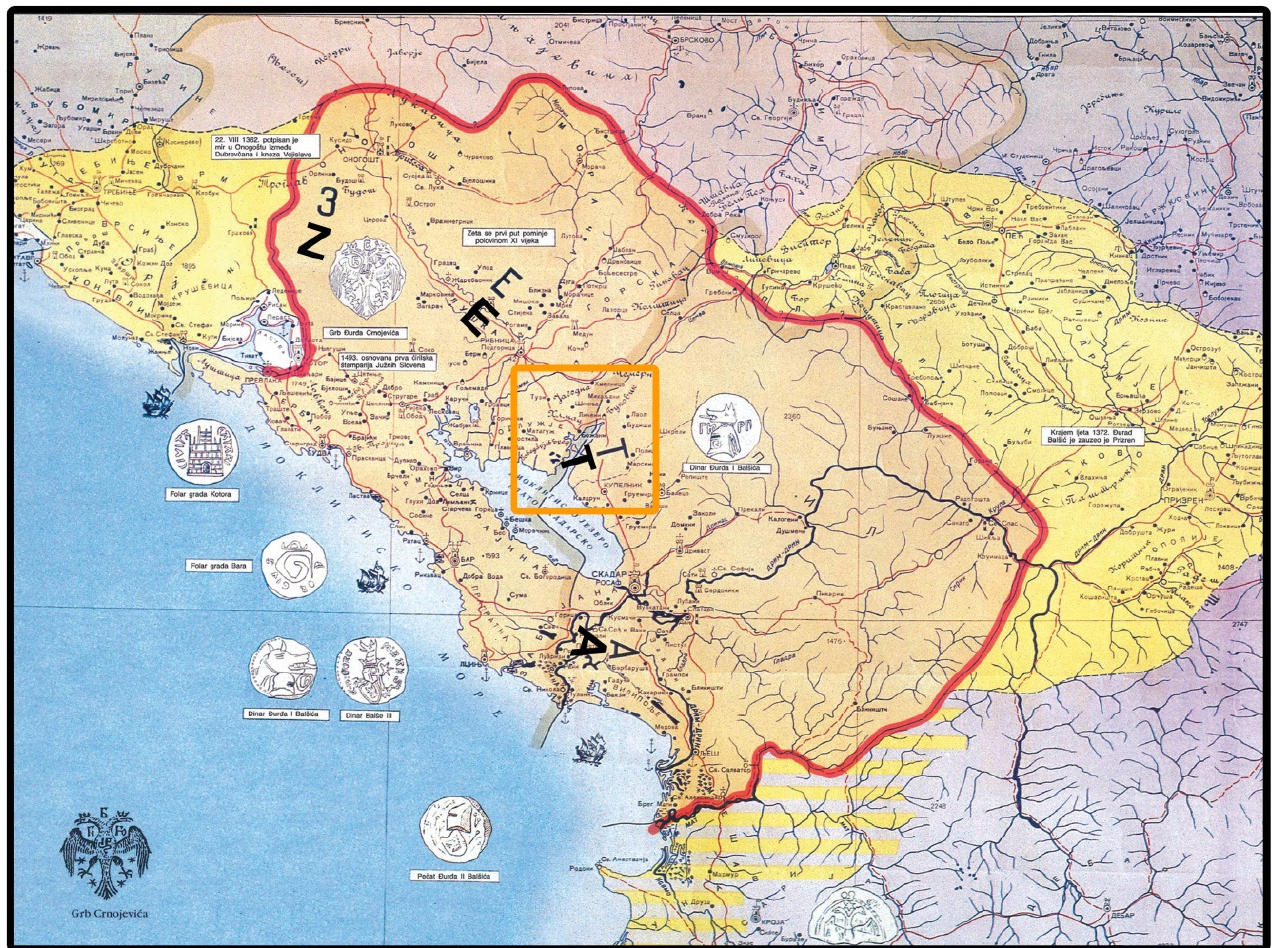
Figure 2. The Zeta region in the 13th century encompassed the area from the Bay of Kotor (Boka Bay) to the rivers Bojana and Drim, and from Ostrog to Podgorica and Skadar Lake. At the end of the 14th century, the territory of Zeta was divided into the Upper and Lower. The Upper Zeta consisted of the area between the mountains Lovcen, Sutorman, Skadar Lake, the river Zeta, Ostrog, Grahovo, and Kotor, while the Lower Zeta stretched from the Lustica peninsula to the river Bojana. The Lower Zeta included Grbalj, Pastrovici, the Bar area with Crmnica and the entire area of the Mountain Rumija, and Ulcinj and Zabojana, the area between Rumija and Bojana (arranged by D. Star č evi ć ).